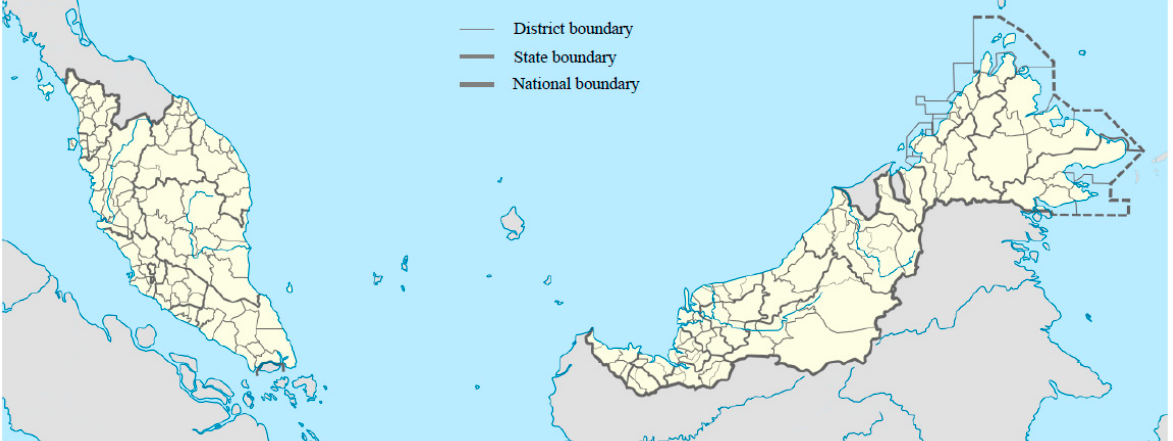
Figure 1. The illustration describes the spatial scale of the entire nation, state, and district in Malaysia. Malaysia is a country comprising 13 states (including three federal territories). In terms of a local district level, a total of 143 districts can be found in Malaysia. Source: Adapted from original “Malaysia Location Map with District” by Hellerick, used under CC BY 4.0.